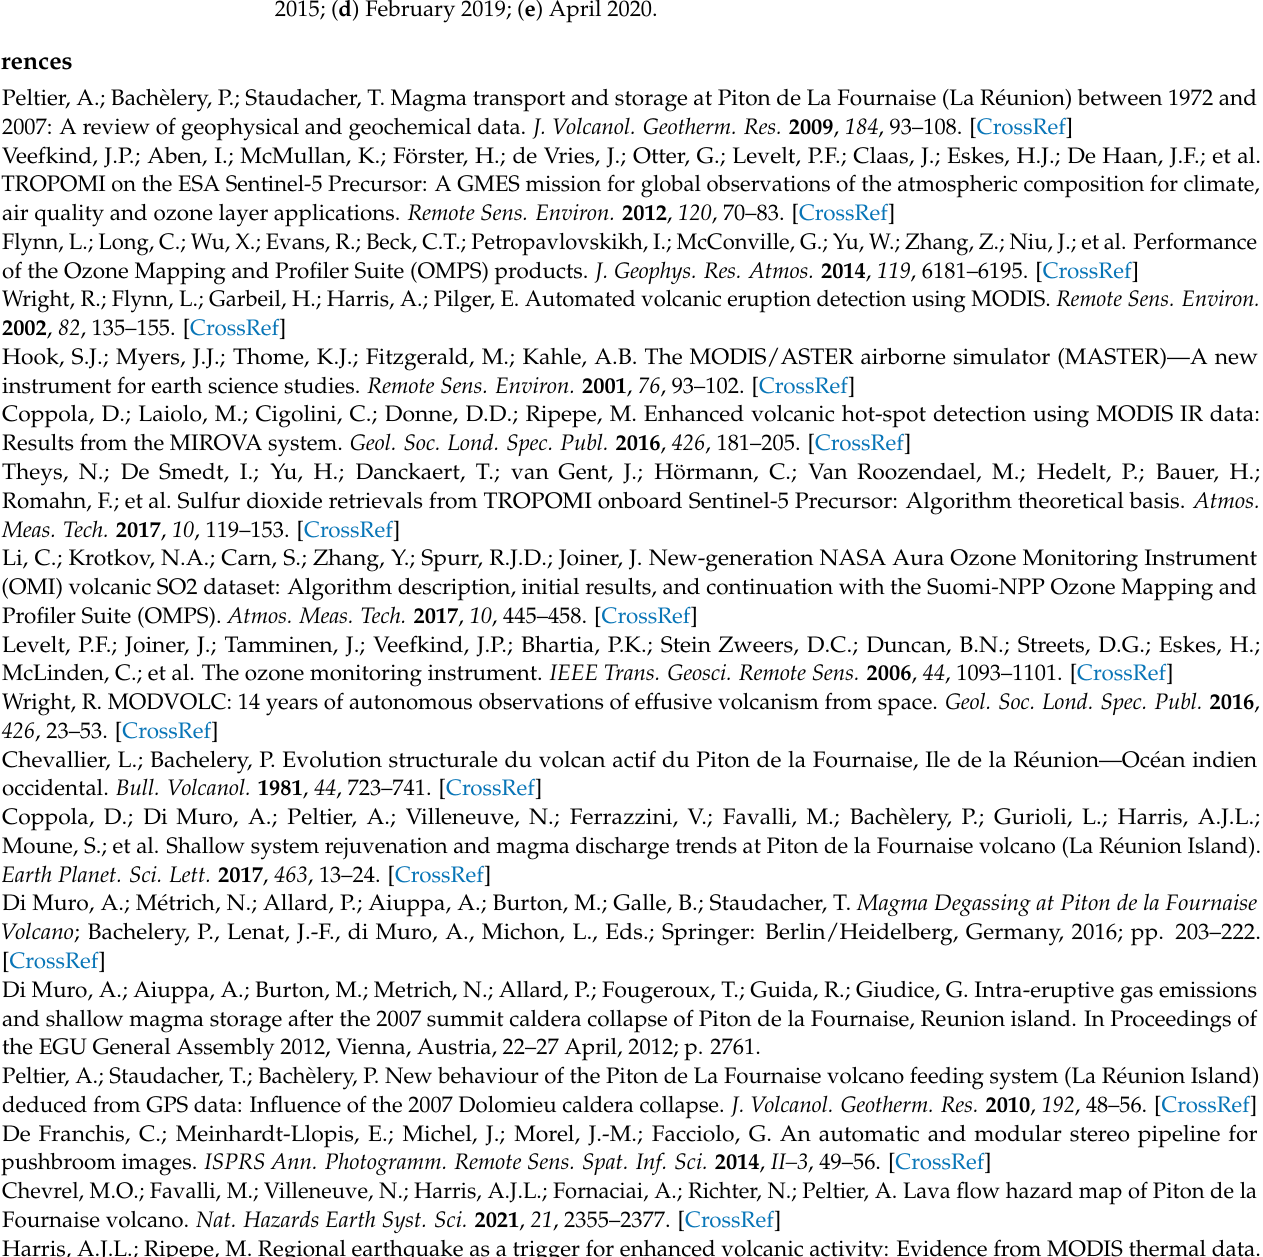
Figure A1. Sulfur dioxide emissions at Piton de la Fournaise during the eruptions of interest recorded by the Ozone Monitoring Instrument (OMI), the Ozone Mapping and Profiler Suite (OMPS), and the Tropospheric Monitoring Instrument (TROPOMI). ( a ) April 2007; ( b ) May 2015; ( c ) August–